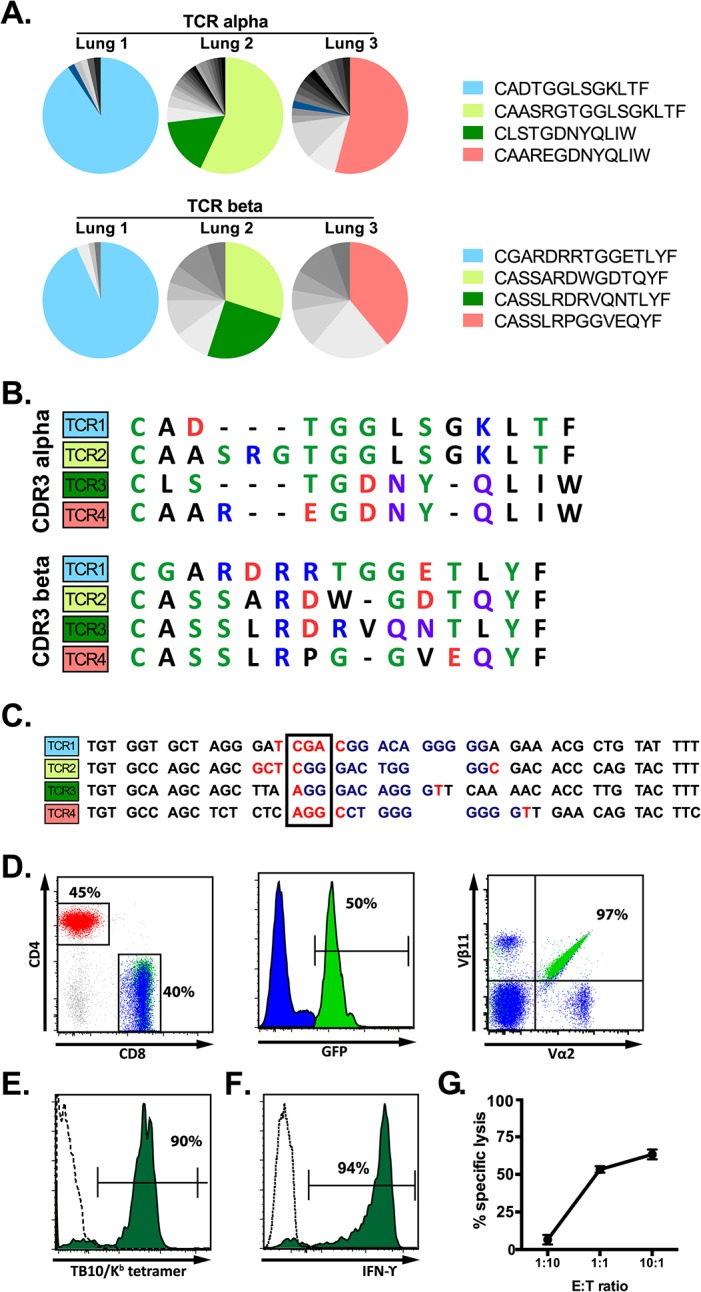
A retrogenic mouse model for TB10-specific CD8+ T cells.(a) Frequency and amino acid sequences of CDR3α (top panel) and CDR3β (bottom panel) regions of TB10.44-11-specific CD8+ T cells from the lung of individual Vα2var mice infected with M. tuberculosis. Data were obtained by single-cell sorting and sequencing of 60–200 cells per mouse (n = 3). (b) Sequences of CDR3α (top panel) and CDR3β (bottom panel) amino acid sequences of the dominant clones of TB10.44-11-specific CD8+ T cells expanded in the lung of Vα2var mice infected with M. tuberculosis. Dashes are gaps introduced for purpose of sequence alignment. (c) VDJ rearrangement (CDR3β) of the dominant TB10.44-11-specific CD8+ clonotypes from the lung of Vα2var mice infected with M. tuberculosis, displaying Vβ (black), N (red), Dβ (blue), and Jβ (black) sequences. Boxed codon is the conserved arginine (Arg, “R”). (d,e) Flow-cytometry analysis of T cells from uninfected retrogenic mice expressing TCR3. (d) Represented are a dot plot of CD4 vs CD8 staining of CD3+ T cells (left panel), histograms of GFP expression within CD8+ T cells (middle panel), and a dot plot of Vα2 vs. Vβ11 staining in CD8+ T cells (right panel). Red, CD4+ T cells; blue, are colored in CD8+GFP- T cells; green, CD8+GFP+ T cells. The numbers represent: the frequency of CD4+ vs. CD8+ T cells among gated CD3+ T cells (left); the frequency of CD3+CD8+ cells that express GFP (middle); and the frequency of CD3+CD8+GFP+ cells that are Vα2+Vβ11+ (right). (e) Tetramer staining of CD8+GFP- T cells (dashed line) and CD8+GFP+ T cells (filled green histogram). The numbers represent the frequency of CD3+CD8+GFP+ cells that are stained by the tetramer. (f) IFNγ production by lung T cells from TCR3 retrogenic mice infected with M. tuberculosis. Lung cells were stimulated with TB10.44-11-peptide and analyzed by intracellular cytokine staining and flow cytometry. Represented are CD8+GFP+ T cells stimulated by TB10.44-11-peptide (filled green histogram) or left unstimulated (dashed line). The numbers represent the frequency of CD3+CD8+GFP+ cells that produce IFNγ after peptide stimulation. (g) Specific lysis of TB10.44-11-peptide pulsed EL4 targets by TCR3 retrogenic T cells at different effector to target ratios. Data are representative of >10 (d, e), >5 (f), and 3 (g) independent experiments.